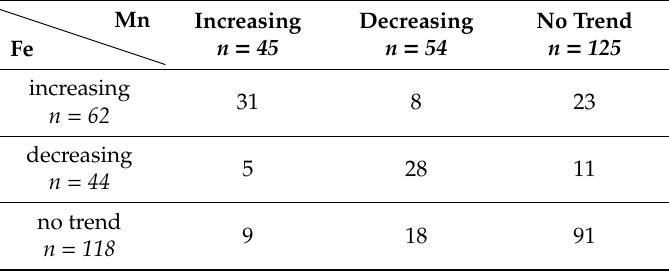
Table 3. Matrix of time series data for Fe and Mn in monitoring wells in the Weser-Ems area. Mn Increasing Decreasing n = 45 n = Fe